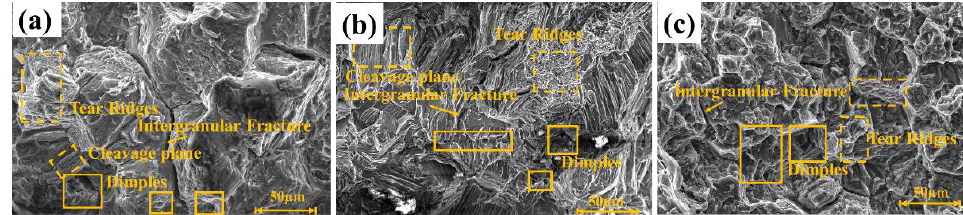
Figure 5. Fractography after tensile test of EV31A Mg alloy in SE mode of ( a ) As-cast; ( b ) T4, and ( c ) T6 conditions. (Solid rectangular box represents “ Dimples ” .)